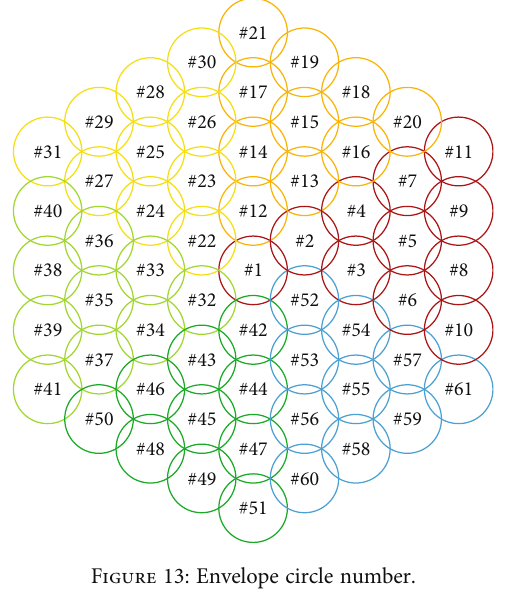
Figure 13: Envelope circle number.